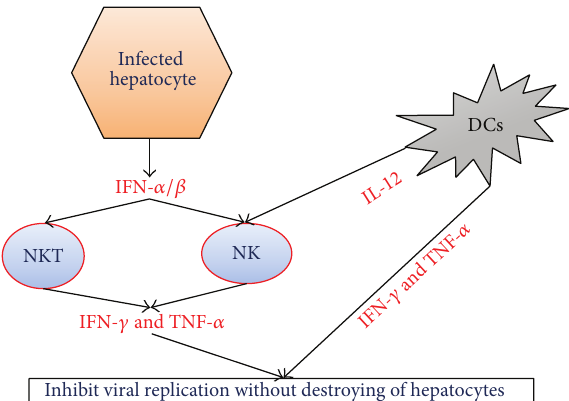
Figure 1: Summary of innate immune response against hepatitis C virus. Infected hepatocyte releases interferon type I ( 𝛼 / 𝛽 ) to activate natural killer (NK) and natural killer T (NKT) cells. Dendritic cells (DCs) also secrete interleukin- (IL-) 12 to activate NKT cells. Those cells later secrete interferon- 𝛾 (INF- 𝛾 ) and tumour necrosis factor- 𝛼 (TNF- 𝛼 ) to inhibit viral replication without causing destruction of the